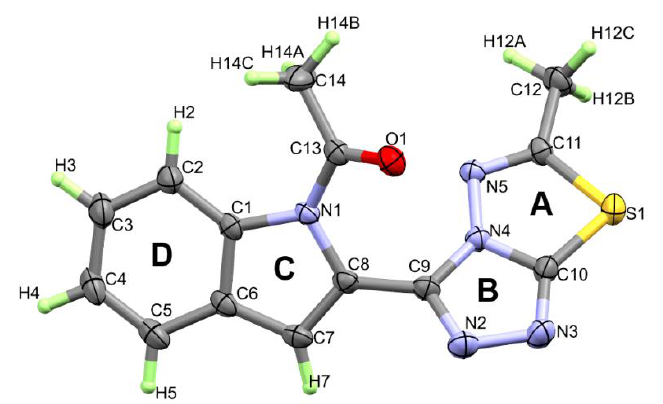
Figure 3. Molecular structure with anisotropic displacement ellipsoids drawn at the 50% probability level of the target compound.